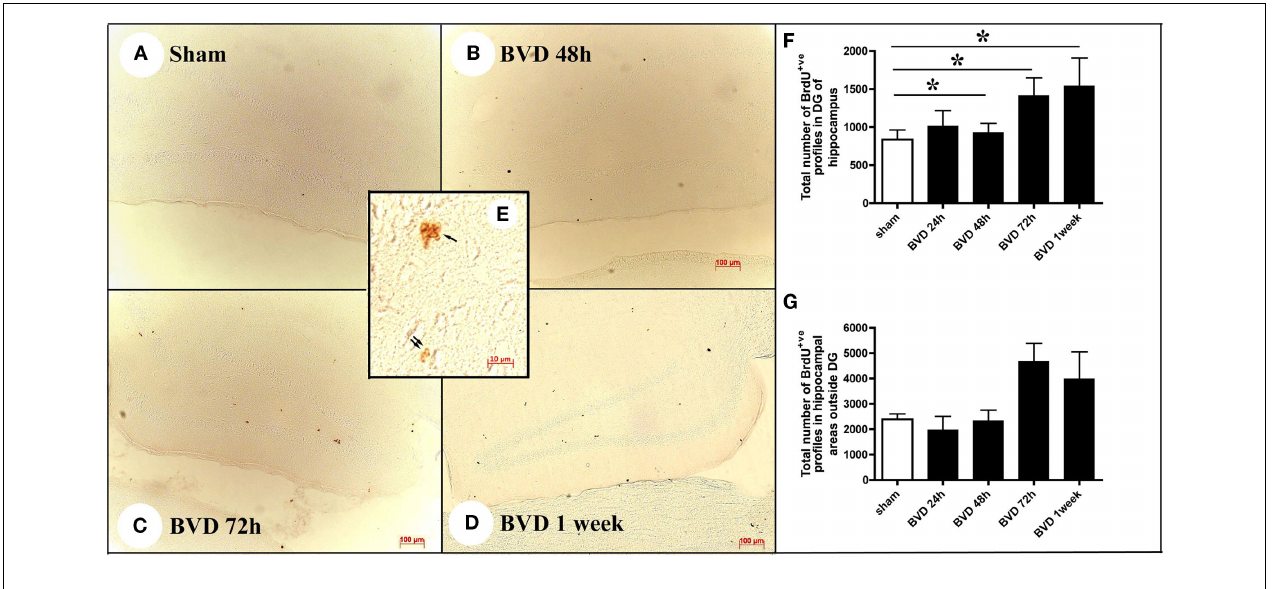
FIGURE 3 | Examples of BrdU immunostaining in sham animals (A) and animals at 48h (B), 72h (C), and 1week (D) following BVD. Inserted picture (E) showing a cluster of BrdU + nuclei in the subgranular layer of the DG (single arrow) and two BrdU + nuclei in the hilus of the